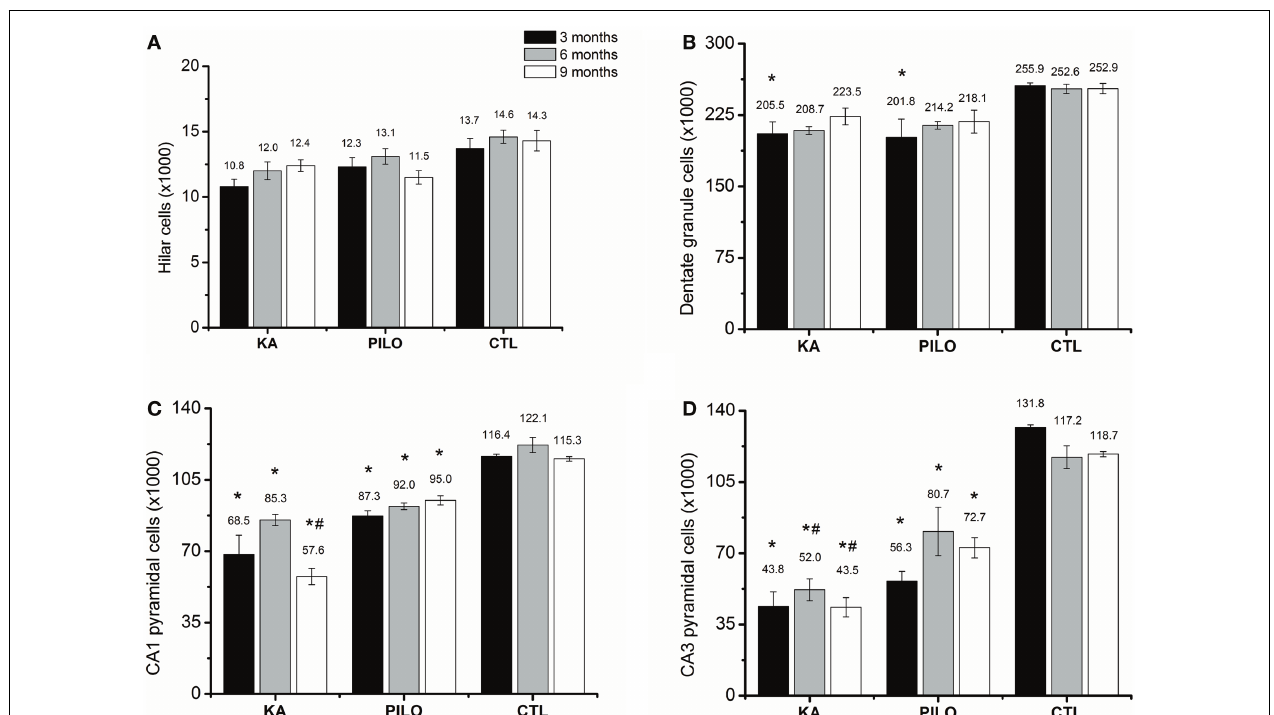
number of pyramidal CA1 (C) is reduced in the KA and PILO groups (* P < 0.01).The same was observed for pyramidal CA3 cells (D) (* P < 0.01). At this time point, the number of pyramidal CA3 cells was lower in the KA than PILO group ( # P < 0.05). Nine months after status, KA and PILO groups had reduction in the number of pyramidal CA1 (* P < 0.01 and * P < 0.05, respectively) and CA3 cells (* P < 0.01 for both groups). At this time point, KA